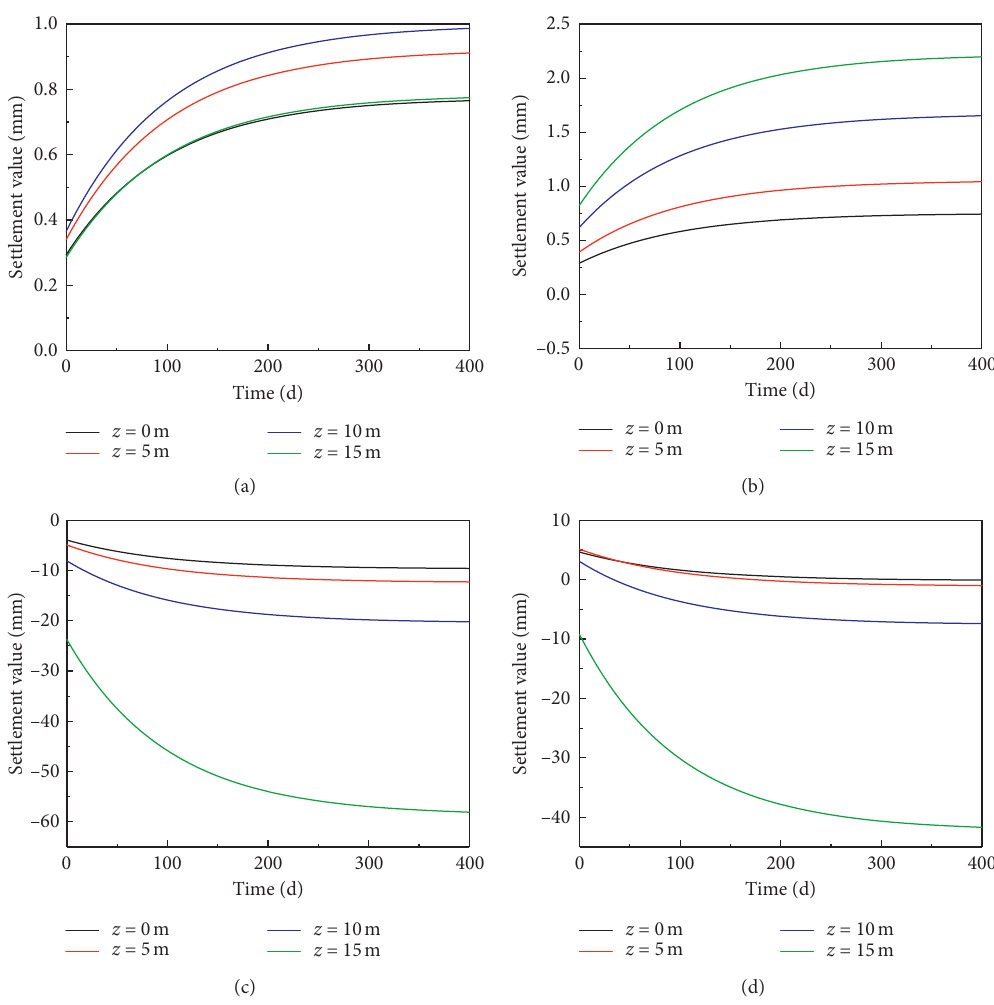
Figure 9: Different calculation depths cause a change in the ground settlement with time under the action of the support pressures (a), shield shell frictions (b), grouting pressures (c), and total displacement over time